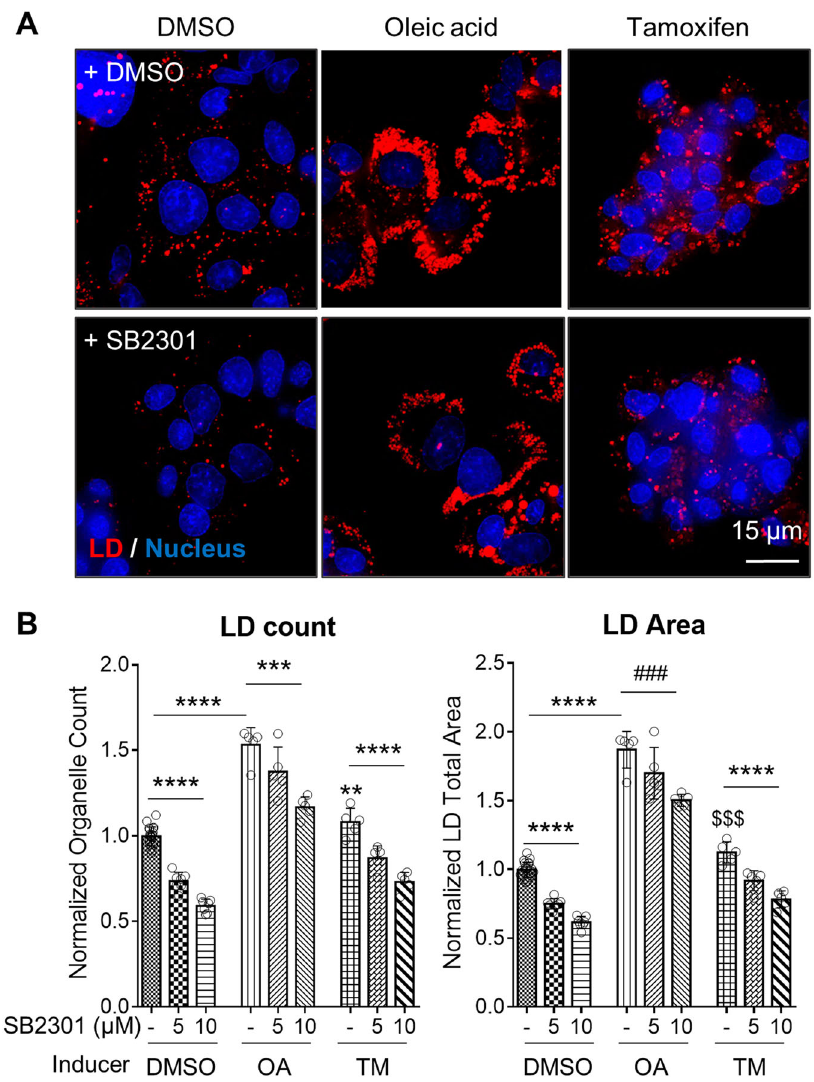
Fig. 6 LD-reducing effects on in vitro drug-induced steatosis models. HepG2 cells were treated with 75 μ M of oleic acid (OA) or 10 μ M of tamoxifen (TM) for 24 h to induce steatosis followed by SB2301 treatment for an additional 24 h. A Representative live-cell fl uorescence LD images of SB2301 in OA- and TM-treated hepatic steatosis models. B Quanti fi cation results of cellular LD count and area from A . All data are represented as dot plots with the mean ± SD, ( n = 3). Data were analyzed using an unpaired t -test. **** P < 0.0001, *** P = 0.001, $$$ P = 0.0002 vs. DMSO, ### P = 0.0004, ** P = 0.0093 vs.